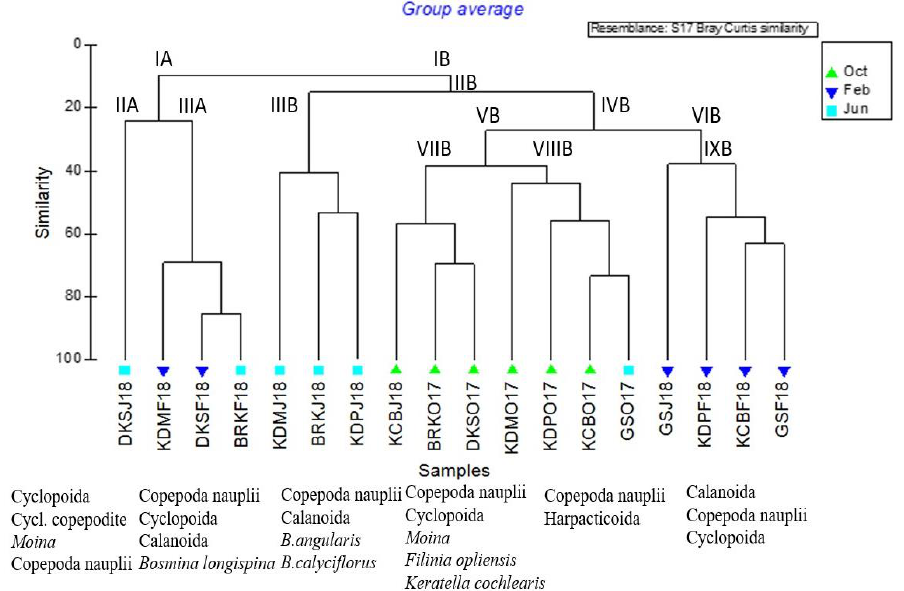
Figure 6. Bray–Curtis similarity of zooplankton and most abundant taxa for each cluster at six sampling stations during (October 2017, February 2018, and June 2018) in the HRE.